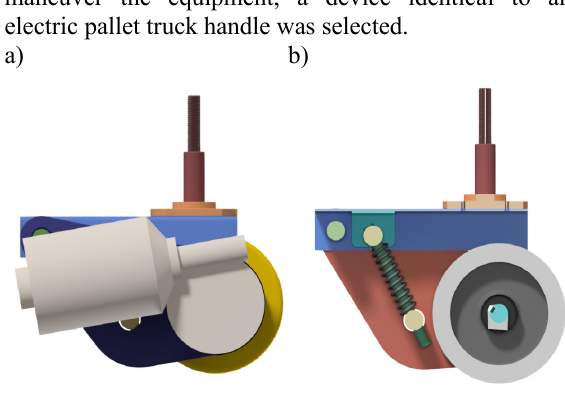
Figure 5. Side (a) and section views (b) of the drive wheel structure of solution B.